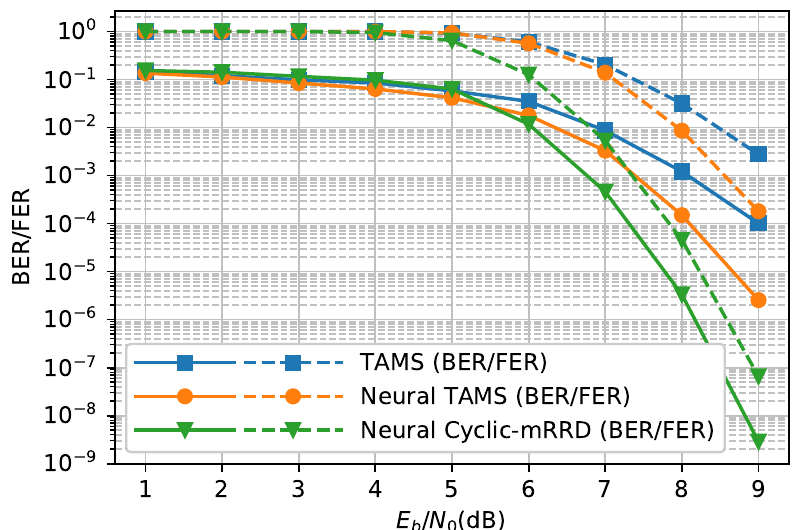
Figure 12. BER/FER performance of different decoders for the (241,121) QR code.